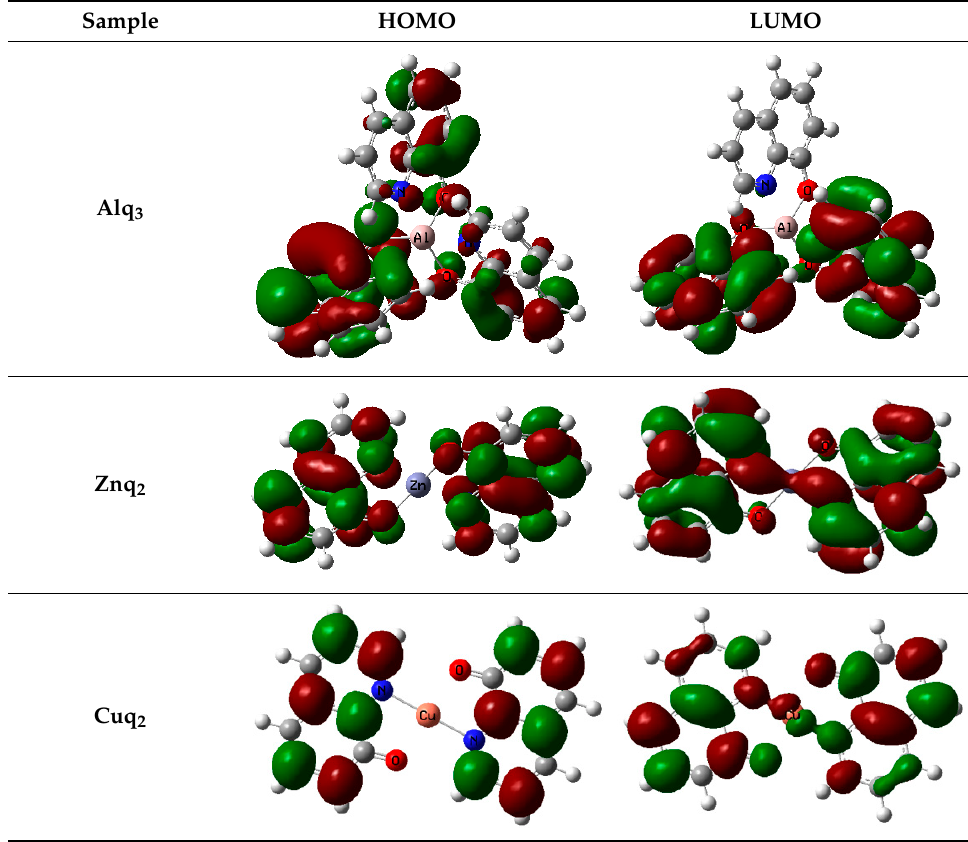
3 , Znq 2 , and Cuq 2 . Table 4. The frontier molecular orbitals: HOMO and LUMO for Alq